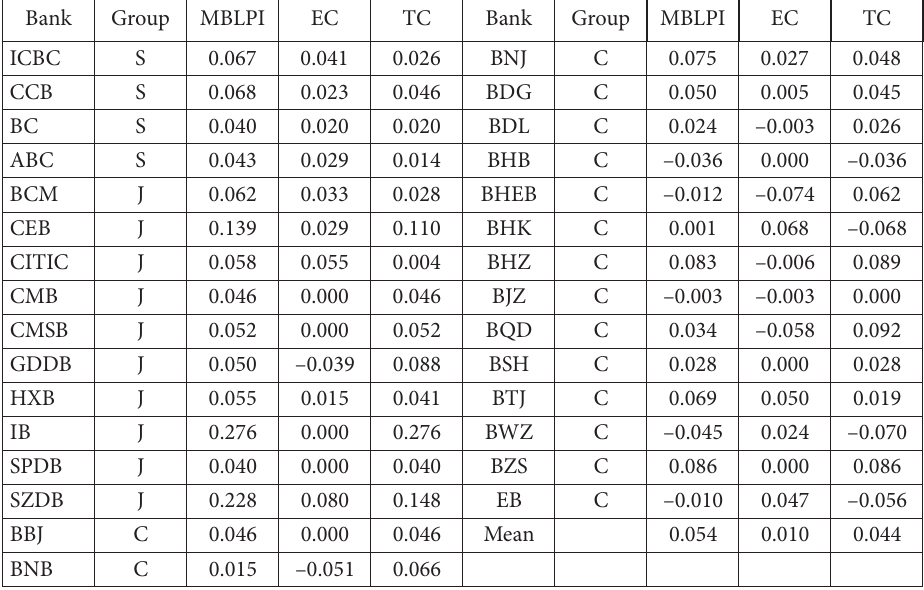
Table 2. Overall TFP growth and its